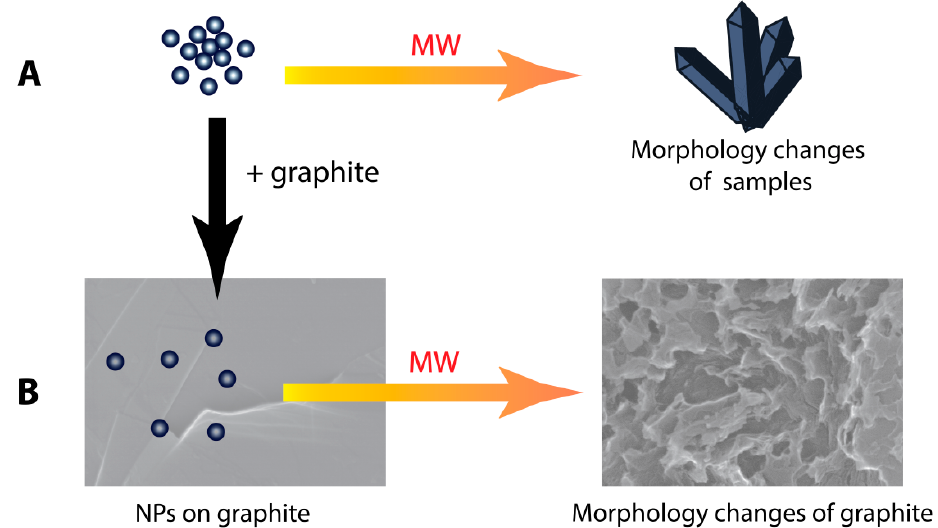
Figure 1. Possible effect of MW-treatment on metal-containing substances ( A ); and MW-treatment effect on graphite support in presence of metal-containing substances ( B ). effect on graphite support in presence of metal-containing substances ( B ).